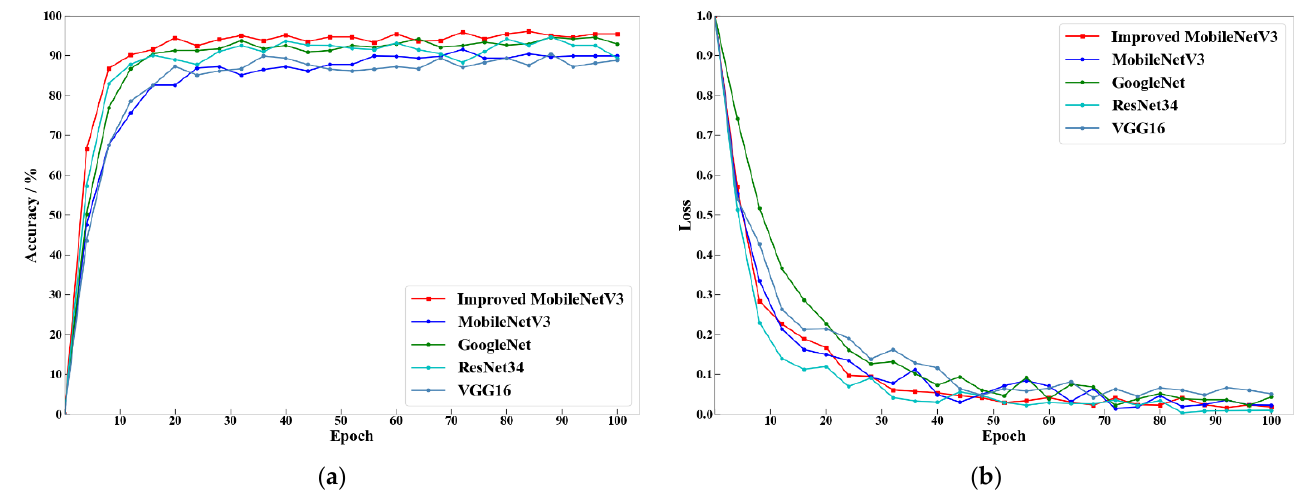
Figure 9. ( a ) The accuracy of validation; ( b ) The value of cross entropy loss function.